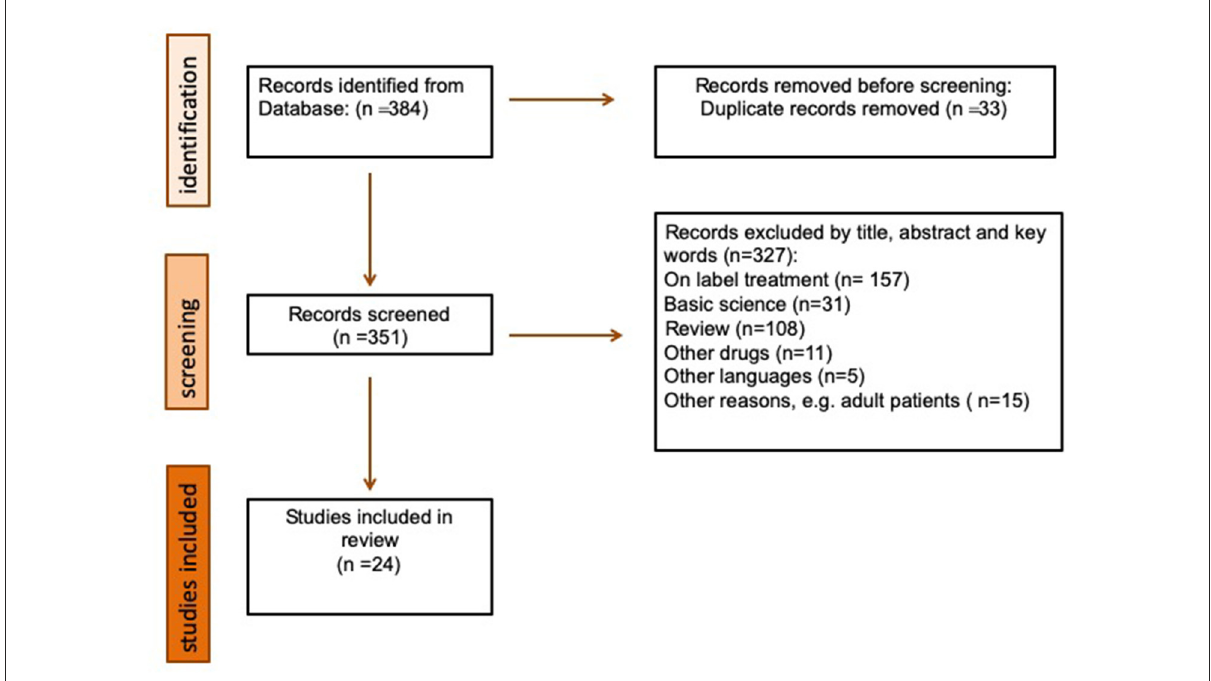
FIGURE1 Flowchart of the literature search and study selection